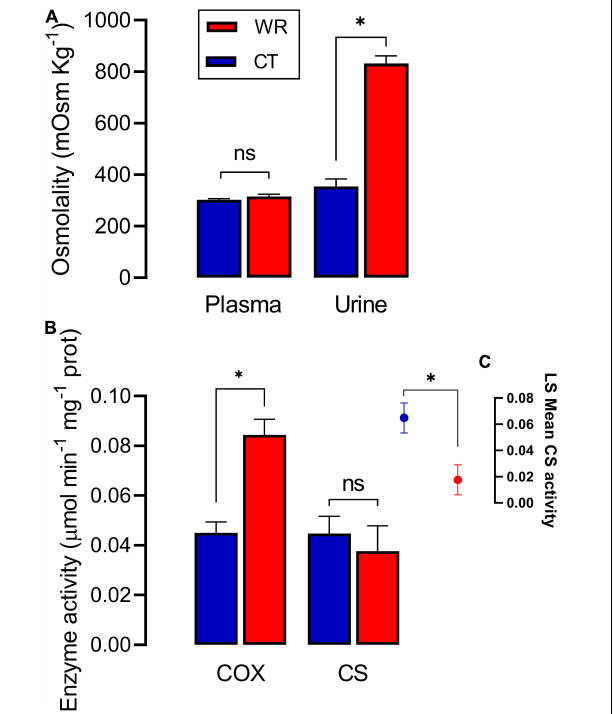
FIGURE 2 | Osmolality of urine and plasma (A) and enzymatic activity of COX and CS (B) in the red blood cells of Z. capensis acclimated to control (CT) and water restriction (WR) conditions. (C) shows the adjusted means of CS activity after controlling for the influence of body mass. Asterisk denotes significant difference between both groups after GLM analyses (see Supplementary Table 1A for detailed statistics). Data are reports as mean ± SE.